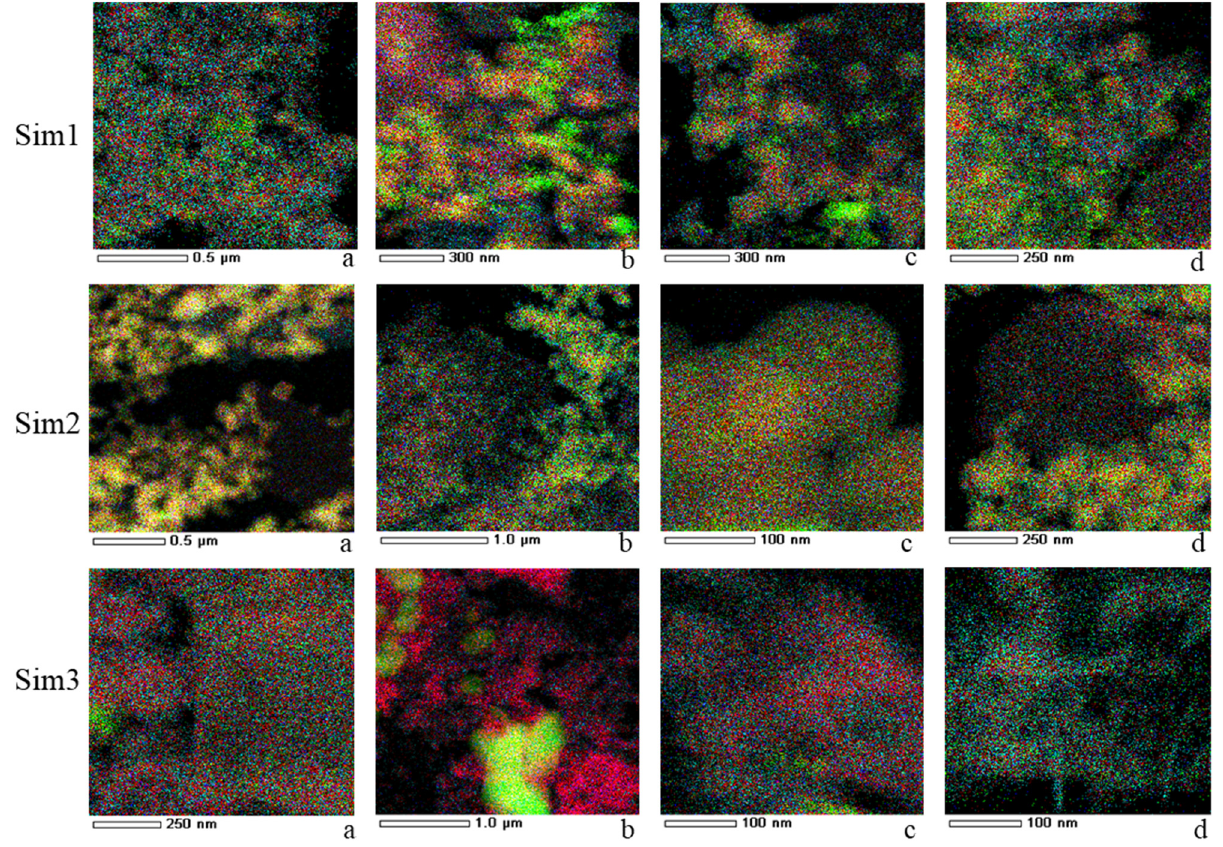
Figure 3: Elemental mapping superposition for Sim1, Sim2 and Sim3 samples. La – light blue, Mn – red and Ni – green. a,b,c,d - di ff erent regions of the same sample with their composition given in Table 2.